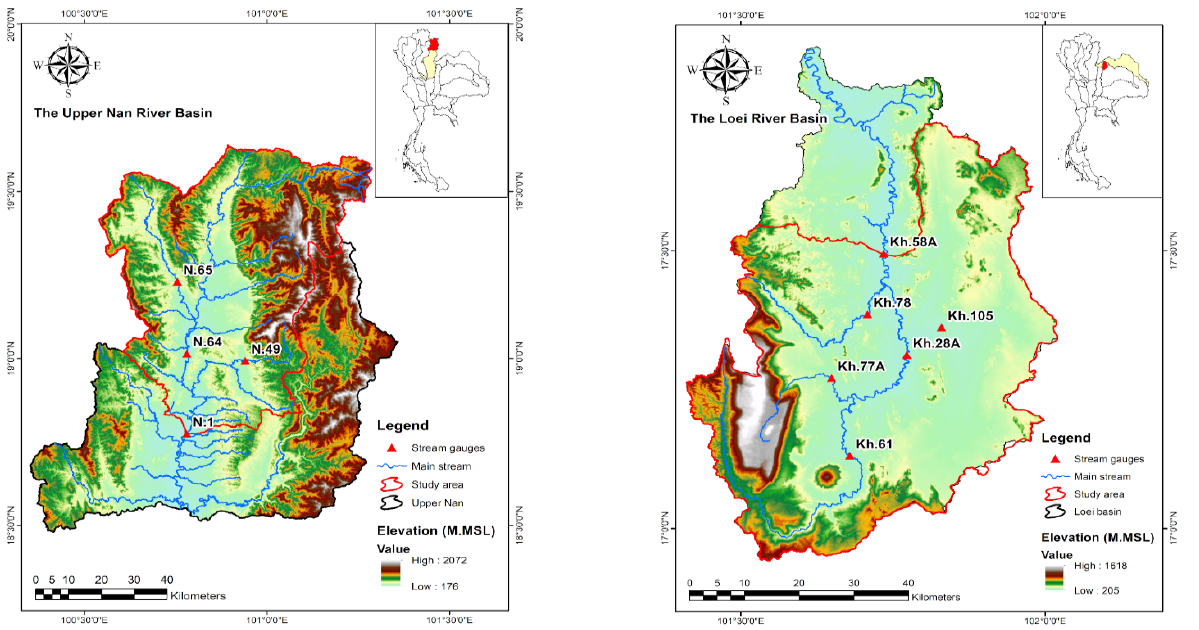
Figure 1. Study area equipped with the stream gauges of the Upper Nan River basin ( left ) and the Loei river basin ( right ).